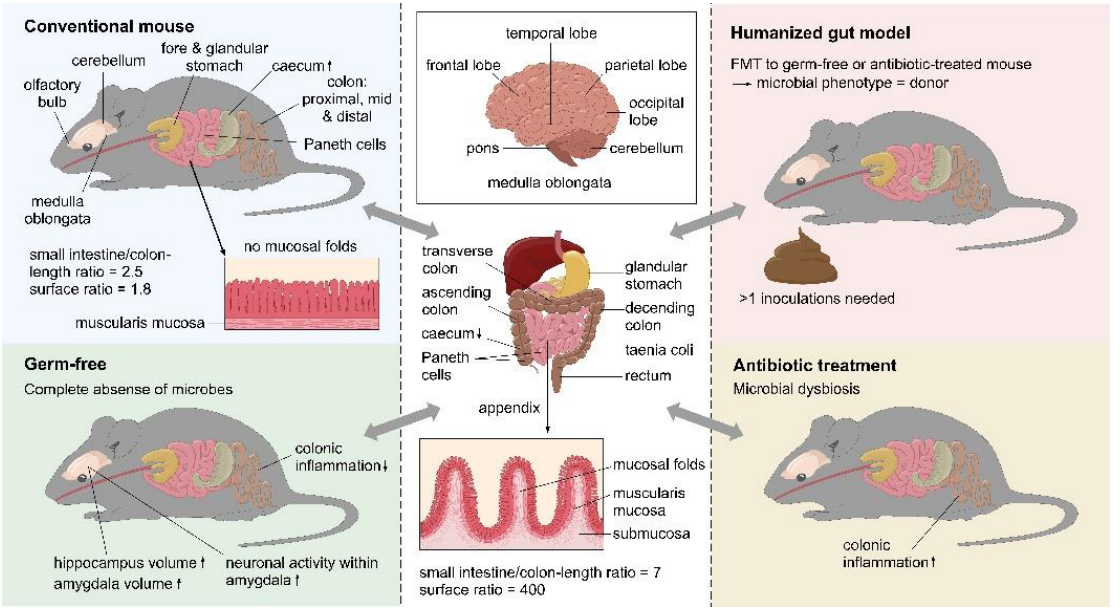
Figure 1. Physiological comparison of the brain and gastrointestinal tract of mice and humans. The differences between a conventional mouse, a germ-free mouse, a humanized mouse, and an antibiotic treated mouse are also shown. The ↑ indicates increased size, while ↓ indicates decreased size. © Pinja Kettunen/SciArt & IFF, with permission.